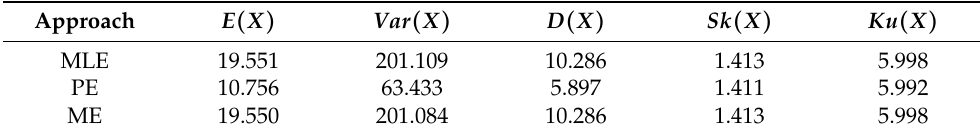
Table 13 lists some numerical accounts of the EDS for the LR data. Table 13. The EDS for LR